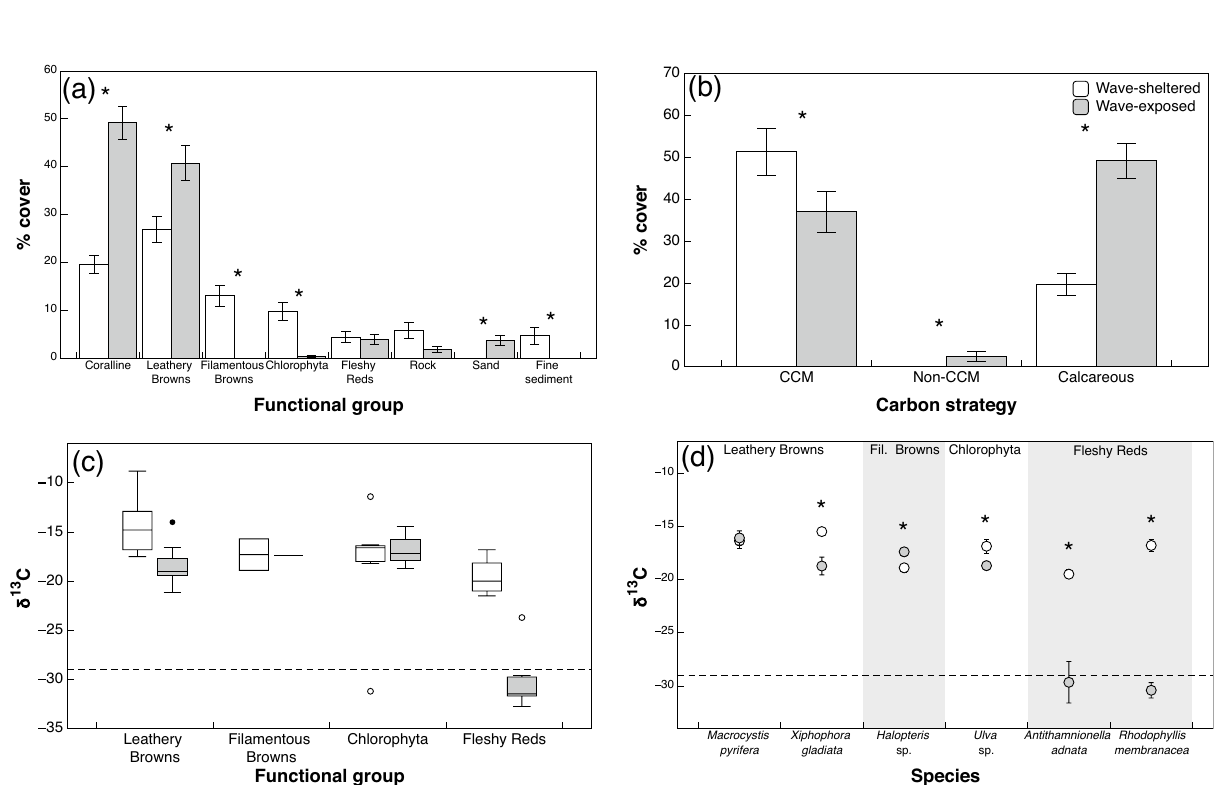
Figure 1. ( a ) Percent cover of functional groups at wave-exposed (grey) and wave-sheltered (white) sites in macroalgal assemblages. Bars represent mean ± 1 SE (n (exposed) = 3, n (sheltered) = 4). ( b ) Percent cover of CCM, non-CCM and coralline species at the wave exposed and wave sheltered assemblages. ( c ) 13 C signatures (δ 13 C) of species present at the two water motion regimes. Species are grouped into functional groups. δ 13 C values that fall below the dashed line at − 29‰ are considered species that solely use carbon dioxide (CO 2 ). ( d ) 13 C signatures for individual species at the wave-exposed and sheltered sites. Points represent mean ± 1 SE (n = 3 to 21). Asterisks (*) indicate a significant difference between water motion regimes (P < 0.05), tested with a Nested ANOVA ( a–c ), or one-way ANOVA ( d